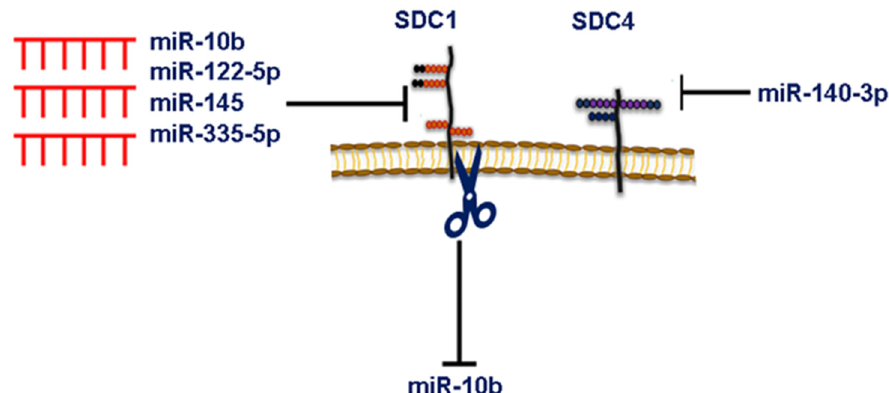
Figure 3. Bidirectional relations between SDCs ( SDC1 and 4 ) and miRNAs in breast cancer. SDC1 expression can be directly or indirectly targeted by miR-10b, miR-122-5p, miR-145, and miR-335-5p, whereas SDC4 is directly targeted by miR-140-3p. On the other hand, downregulation of SDC1 results in reduced miR-10b expression. The interplay between SDCs and miRNAs ultimately affects breast cancer cell behavior (e.g., cell proliferation, adhesion, migration, and invasion).